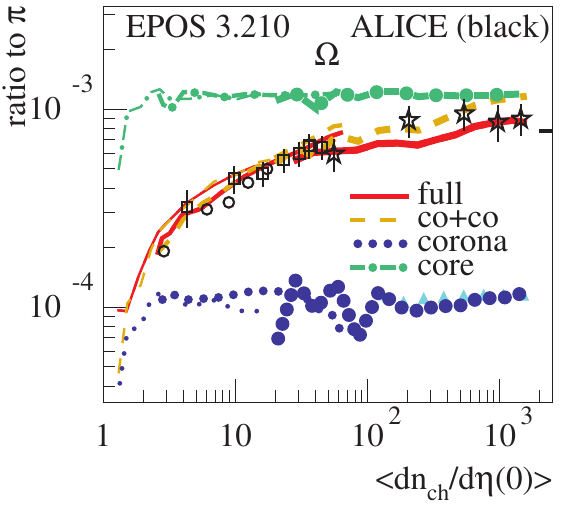
Figure 5. Particle to pion ratio for the Ω baryon versus multiplicity at mid-rapidity, for di ff erent contributions (core (dash-dotted), corona (dotted), core + corona (dashed) and all (core + corona + hadronic gas) (full)) from the E pos simulations, for di ff erent systems (pp (thin), pPb (normal), PbPb (bold)). We also plot ALICE data from [7].